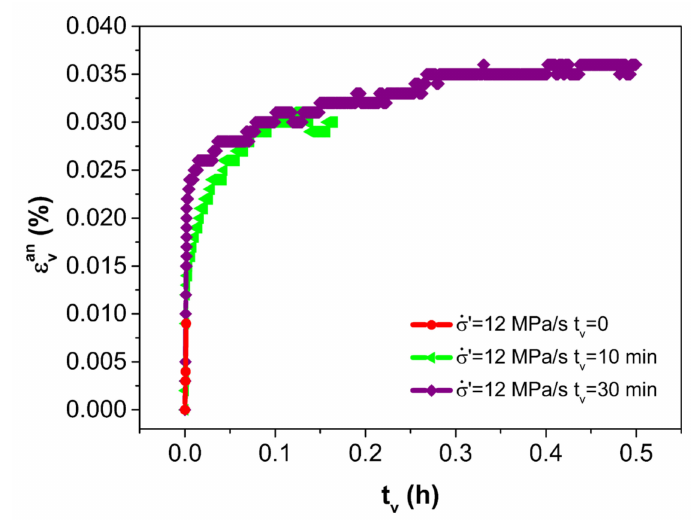
Figure 9. Evolutions of anelastic recovery strain near valley stress ε an v with time of the second cycle for di ff erent durations under valley stress.